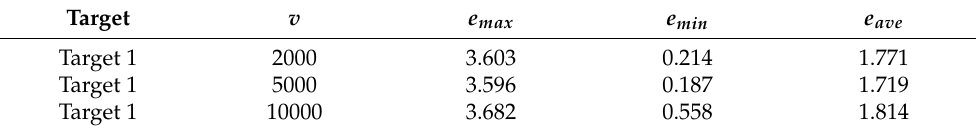
Table 5. Comparison of positioning errors with different velocity of target 1.